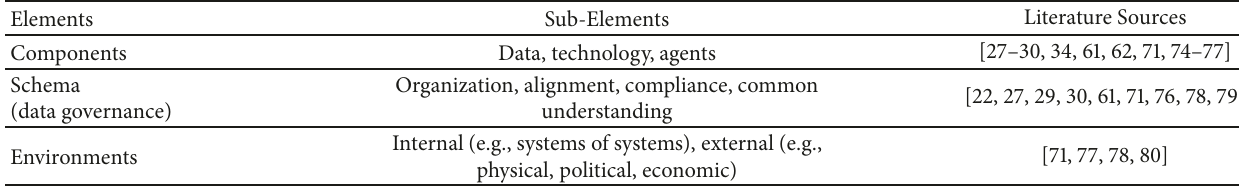
Table 2: CAS elements of asset management data